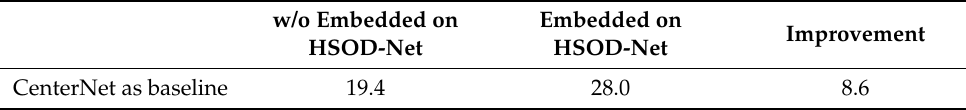
Table 6. Quantitative Comparison on COCO 2014 Dataset.